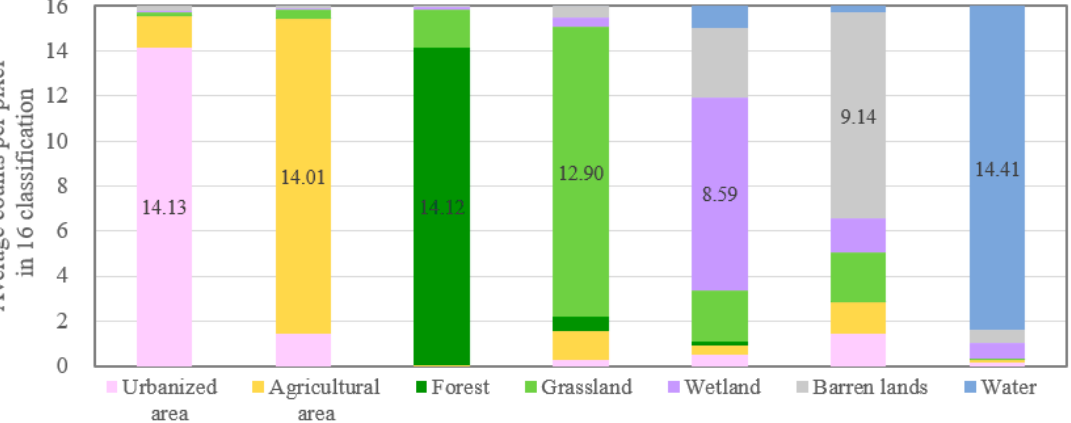
Figure 7. Average counts for different land covers from the 16 different perspective classifications.